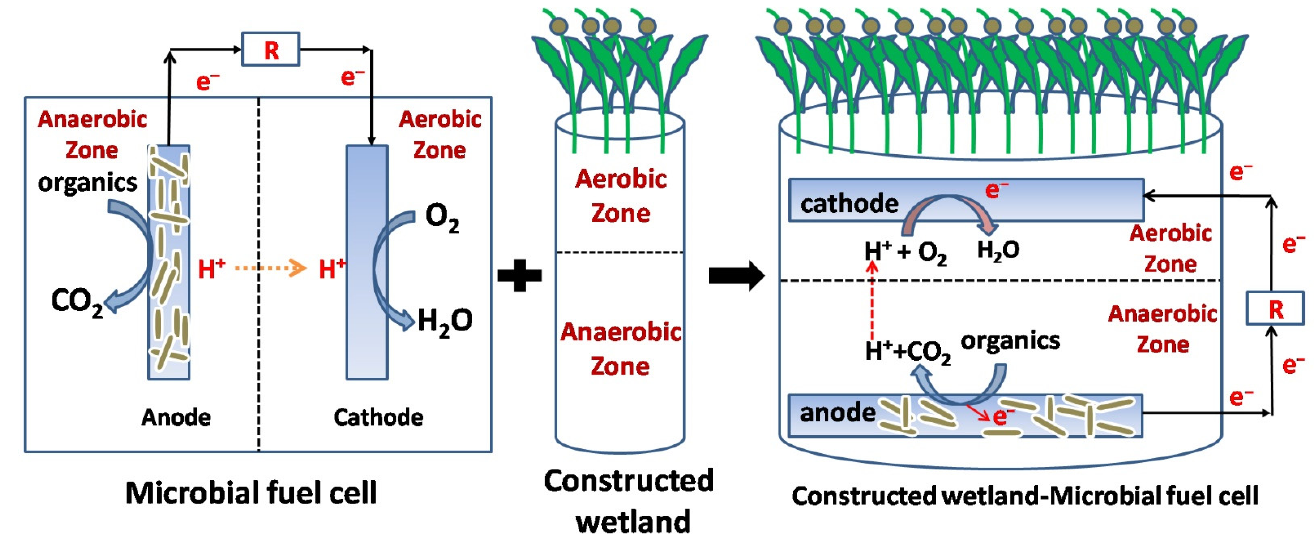
Figure 13. The similarities between microbial fuel cell (MFC) and constructed wetland (CW) configurations. Reproduced with permission from Ganiyu et al., Bioresour. Technol . [178]; published by Elsevier, 2021. Table 4. Hybrids of constructed wetlands coupled with microbial fuel cells (CWs–MFCs) for antibiotic removal.